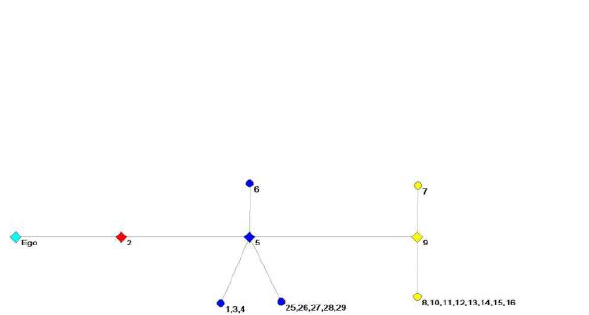
Fig.11. The tree of the deconstruction of Marc's